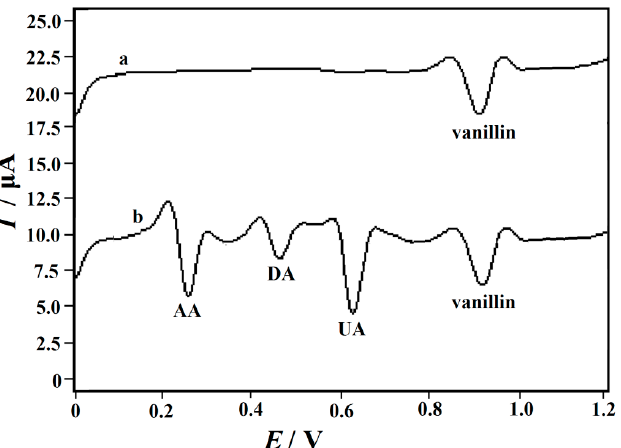
Figure 10. SDLSVs obtained at the CeO 2 /ERGO/GCE in 0.1 M HCl solution containing (a) 1.0 µM vanillin; (b) 1.0 mM AA+ 10 µM DA + 10 µM UA + 1.0 µM vanillin. Accumulation potential: 0.1 V, accumulation time: 120 s, scan rate: 0.1 V s − 1 .